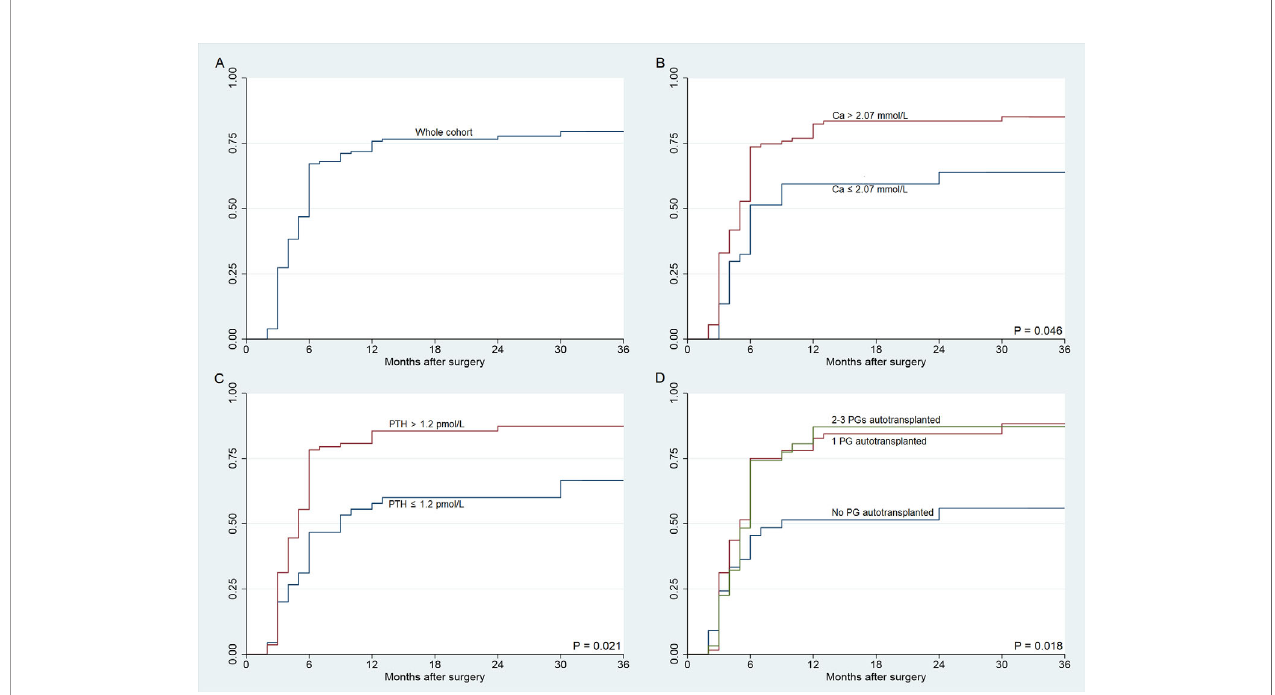
FIGURE 2 | Time to recovery of the parathyroid function in patients with protracted hypoparathyroidism. (A) Time to recovery of the parathyroid function for the whole cohort (n = 128). (B) Recovery of the parathyroid function according to serum calcium concentration at one month. (C) Recovery of the parathyroid function according to parathormone at one month. (D) Recovery of the parathyroid function according to parathyroid glands autotransplantation. Horizontal axis uses logarithmic scale (months). P values from the Log Rank (Mantel – Cox)